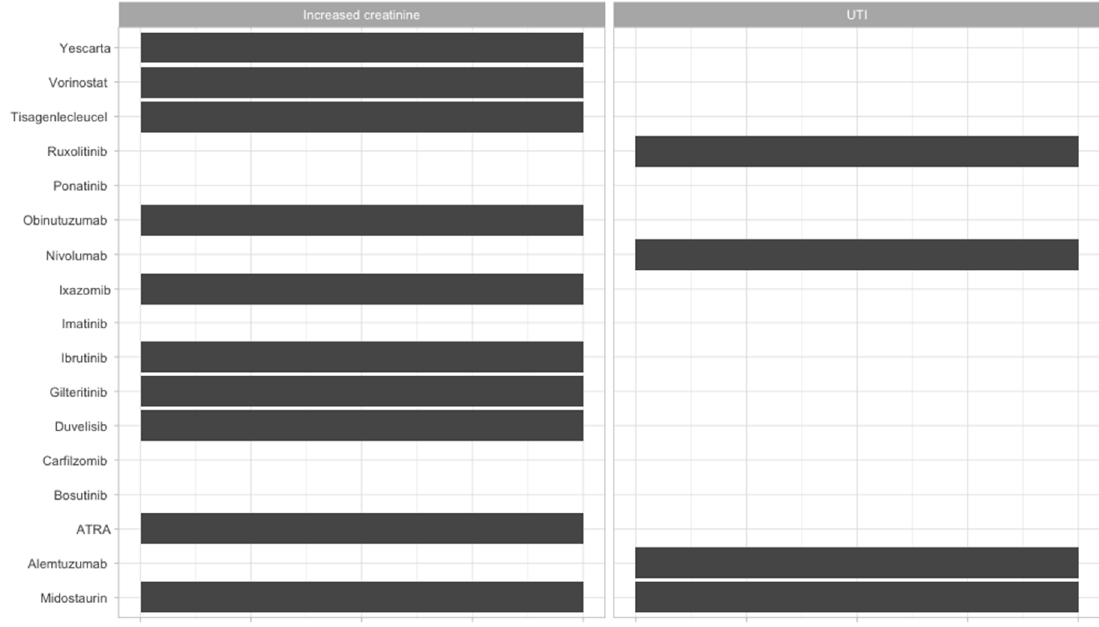
Figure 5. Renourinary side-effects of FDA-approved and non-approved drugs for hematological disorders. UTI = urinary tract infection.